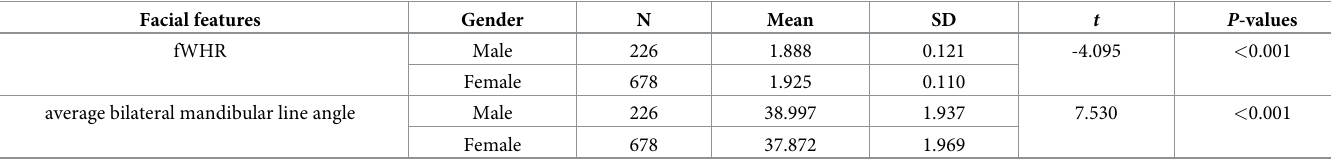
Table 1. Comparison of fWHR and average bilateral mandibular line angle means between male and female with T tests. Facial features Gender